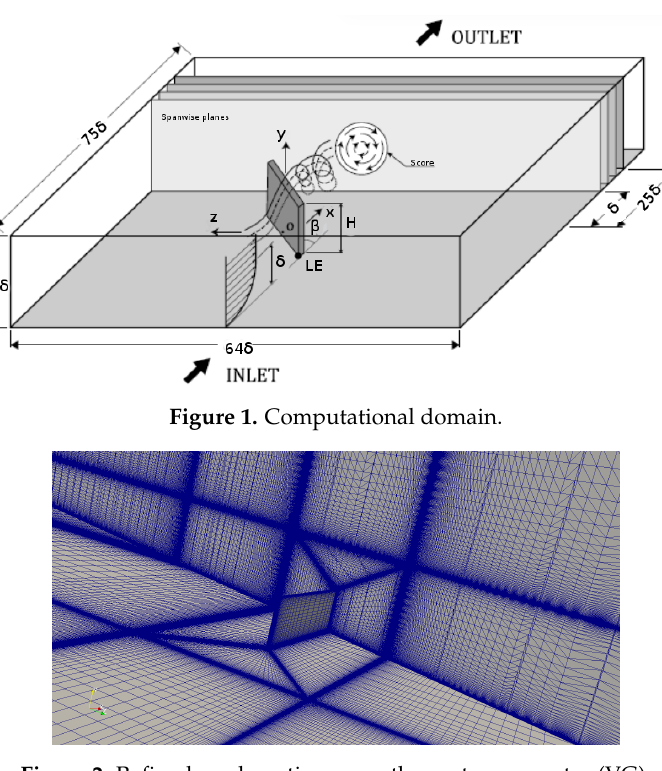
Figure 2. Refined mesh sections near the vortex generator